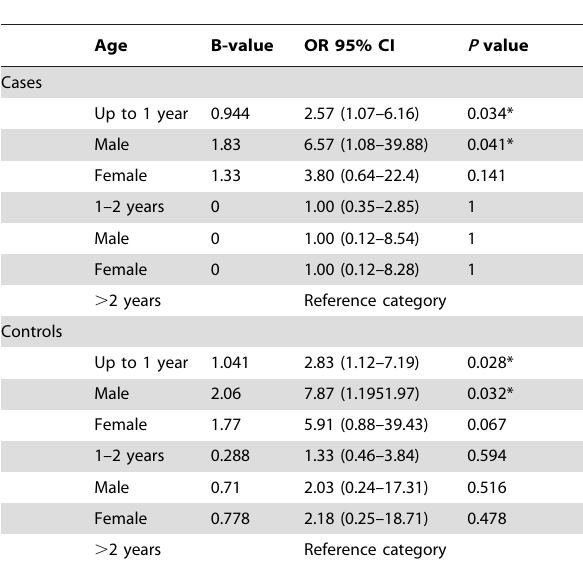
Table 1. Multinomial Logistic Regression Models exploring significant risk age group of ETBF infection.